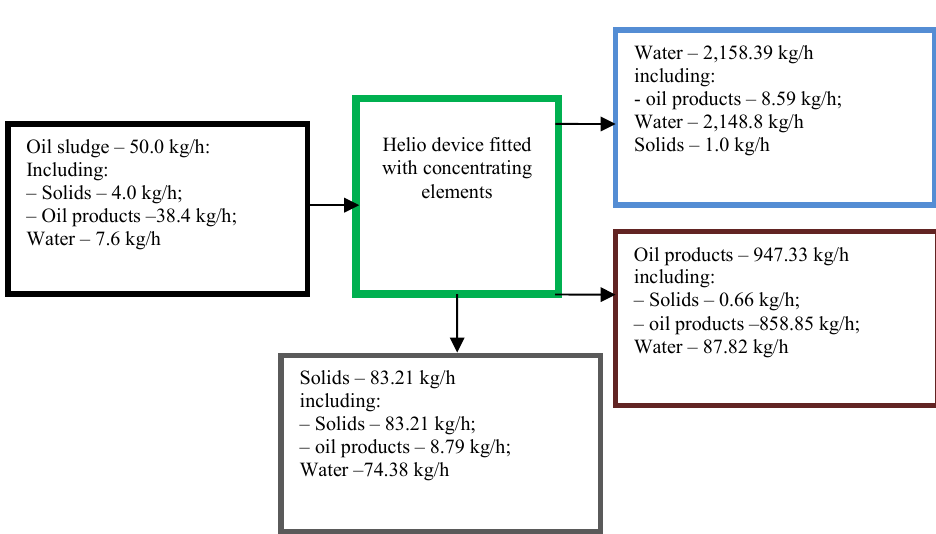
Fig. 7. Diagram of oil sludge passage through the helio device